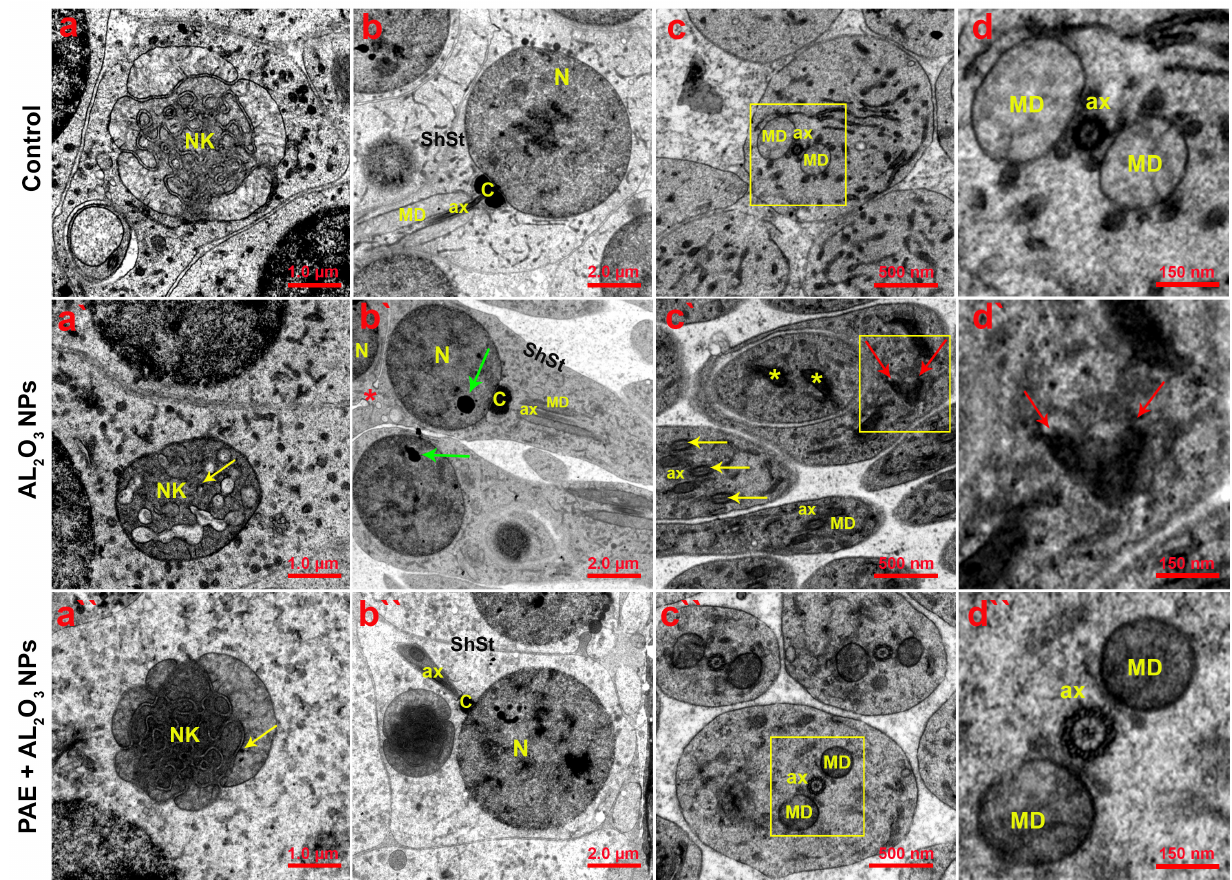
Figure 13. This is a figure. Schemes follow the same formatting. If there are multiple panels, they Figure 13. Ultrastructural analysis of the locust testis using TEM after Al 2 O 3 NPs injection with or without PAE treatment. Electron micrographs in Figures ( a – a `` ) reveal the difference in the should be listed as: ( a ) Description of what is contained in the first panel. ( b ) Description of what is structure of the mitochondrial nebenkern (NK) associated with the early spermatid stage in the contained in the second panel. Figures should be placed in the main text near to the first time they control group, the Al 2 O 3 NPs-treated group, and the PAE + Al 2 O 3 NPs-treated group, respectively. are cited. A caption on a single line should be centered. Figure ( a ) shows the typical structure of NK characteristics for L. migratoria . Figure ( a ` ) depicts the NK alterations as disintegrated NK with many vacuoles containing nanoparticles (arrow) in Table 1. This is a table caption. Tables should be placed in the main text near to the first time they locust follicular cysts exposed only to Al 2 O 3 NPs. Figure ( a `` ) demonstrates the normal integration are cited. of the NK similar to that of the control group even with the accumulation of Al 2 O 3 NPs within it (arrow). Electron micrographs in Figures ( b–b `` ) show the short spermatid (ShSt) stage in the control group, Al 2 O 3 NPs-treated group, and PAE + Al 2 O 3 NPs-treated group, respectively. Figure ( b ) shows the typical structures of the short spermatid (ShSt), nucleus (N), centriole (C), axonemes (ax) and two mitochondrial derivatives (MD). Figure ( b ` ) shows a short spermatid (ShSt) agglutinated head-to-head (*), nuclear dense vesicles of aggregated nanoparticles (arrows) (which could not be assessed with TEM